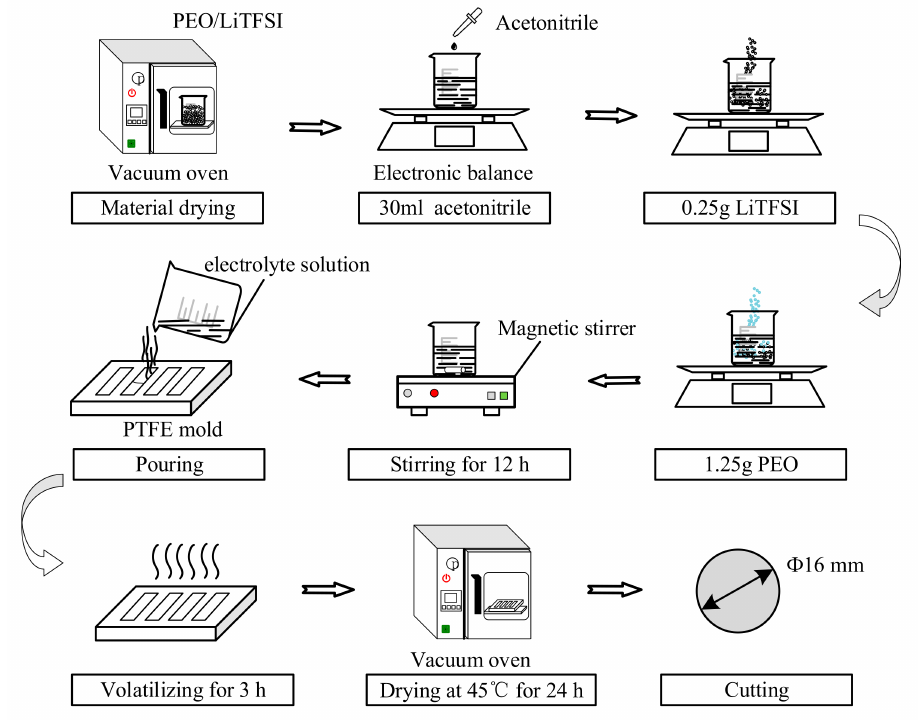
Figure 2. Preparation process of the solid electrolyte membrane.